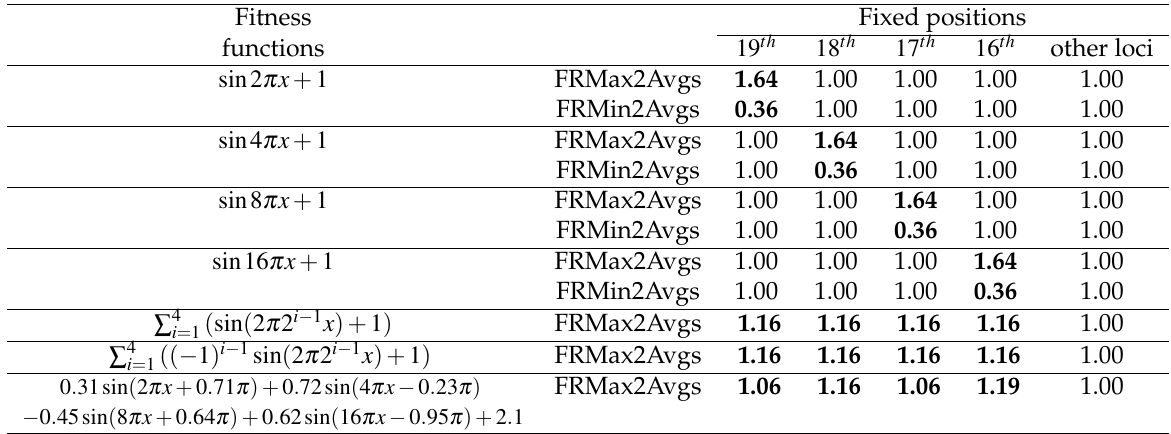
Table 1. The FRMax2Avgs and FRMin2Avgs for sin ( 2 π 2 i − 1 x )+ 1 , i ∈ { 1 , ··· , 4 } and the FR- Max2Avgs for some of their combinations under the base-2 encoding of string length 19.